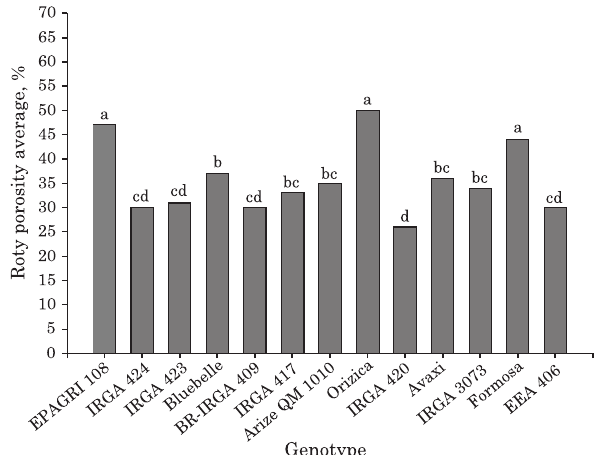
Figure 3. Average relative porosity in three segments of adventitious roots of rice genotypes produced under conditions of hypoxia. Lowercase letters compare genotypes by the LSD test